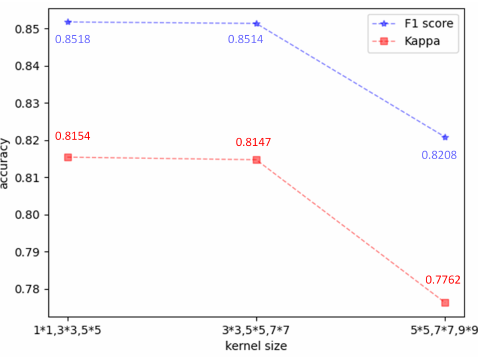
Figure 18. The effects of kernel size in SCKB module on the accuracy of MSAK-Net.